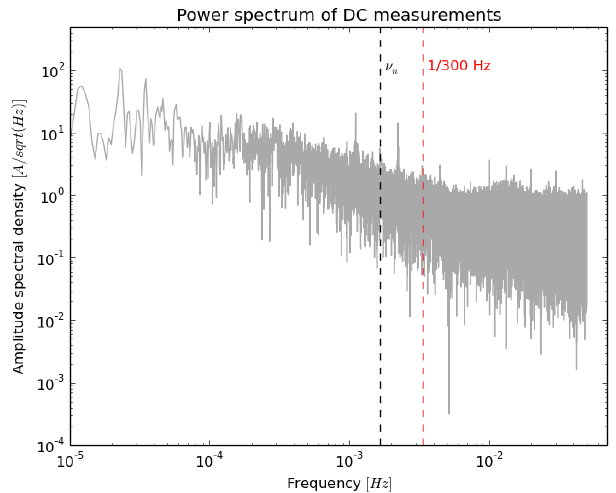
Figure 8. Power spectrum of DC measurements. The window used in our analysis as well as the associated Nyquist frequency of that window ( ν n ) are displayed as red and black lines, respectively. The two defined spikes in the spectrum around 10 − 3 Hz result from pe- riodic 15 and 7.5min signals related to the power